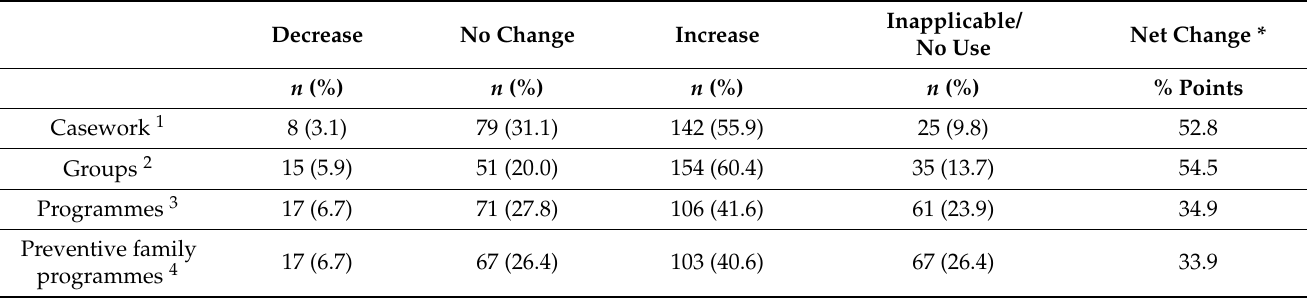
Table 3. Changes in perceived ICT use in family service components during the COVID-19